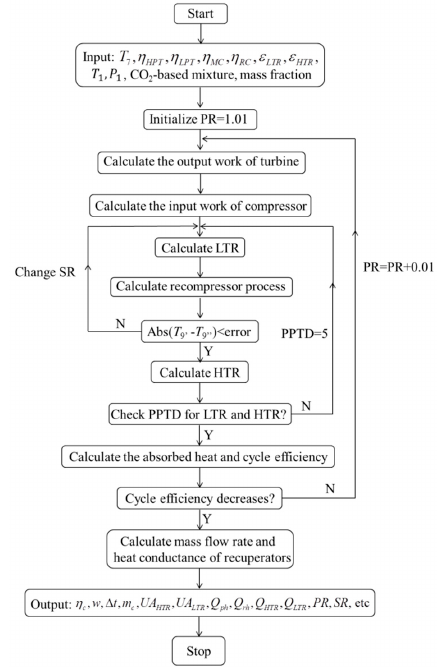
Figure 5. Calculation flow chart of the cycle with CO 2 -based mixtures.